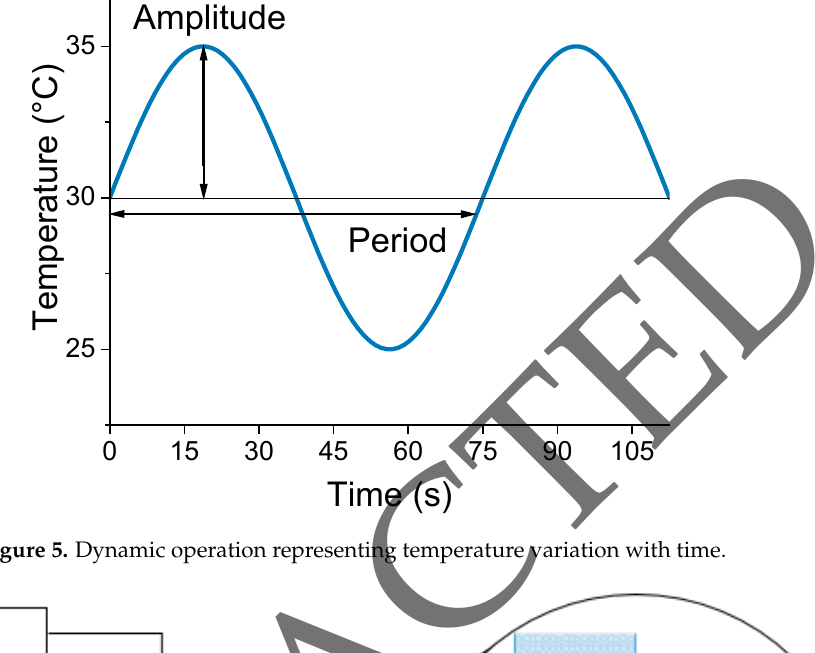
Figure 5. Dynamic operation representing temperature variation with time.